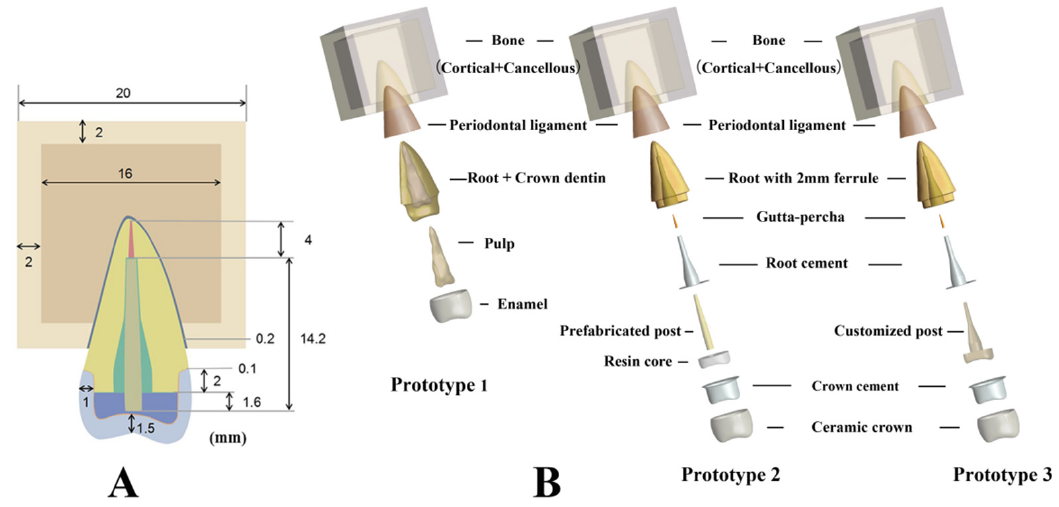
Figure 1. Dimension and establishment of three finite element Prototypes. ( A ) Dimension of Proto- types. ( B ) Structure of three Prototypes.